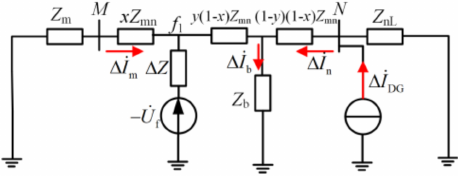
Figure 8. Composite sequence network of the positive-sequence fault component: the UBL is downstream of the fault point in case of an internal